Question: What visual encoding does this figure use to show its data?
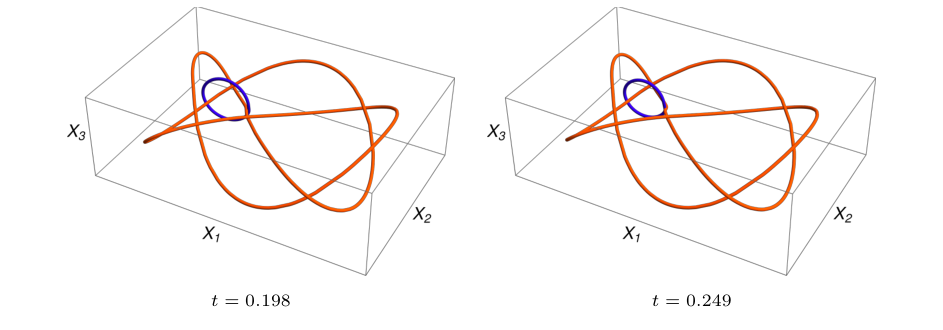
Answer: line